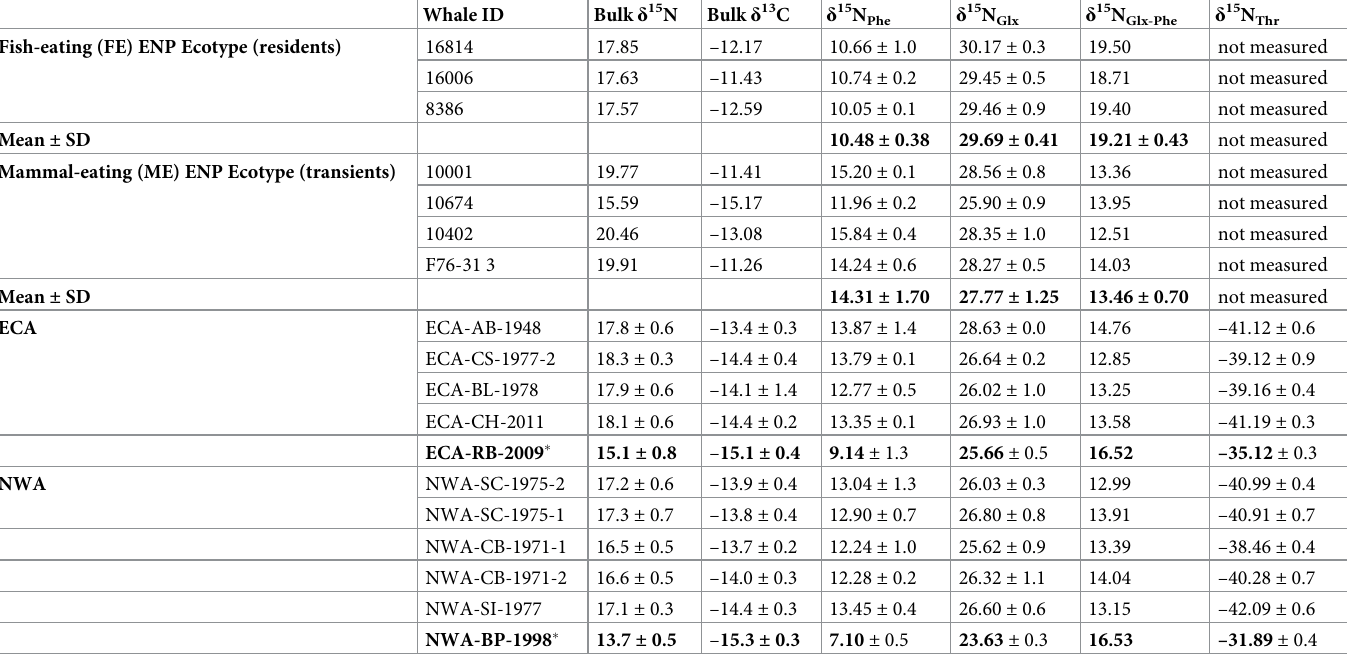
Table 2. Bulk δ 15 N and δ 13 C values and phenylalanine (Phe), glutamic acid/glutamine (Glx), and threonine (Thr) δ 15 N values (‰) measured in dentine collagen of killer whale ( Orcinus orca ) ecotypes from the eastern North Pacific (ENP), and killer whales from the eastern Canadian Arctic (ECA) and Northwest Atlantic (NWA) with unknown